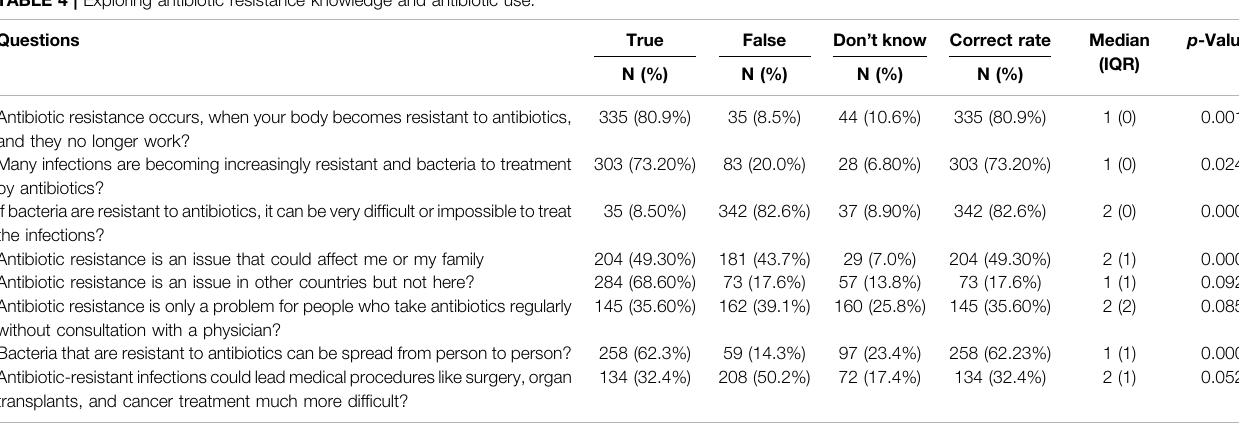
TABLE 4 | Exploring antibiotic resistance knowledge and antibiotic